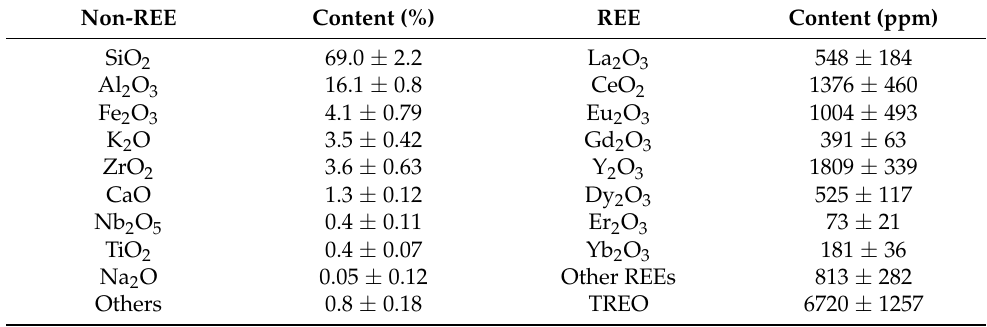
Table 1. Elemental composition of REE-bearing sample from the Khalzan Buregtei deposit,